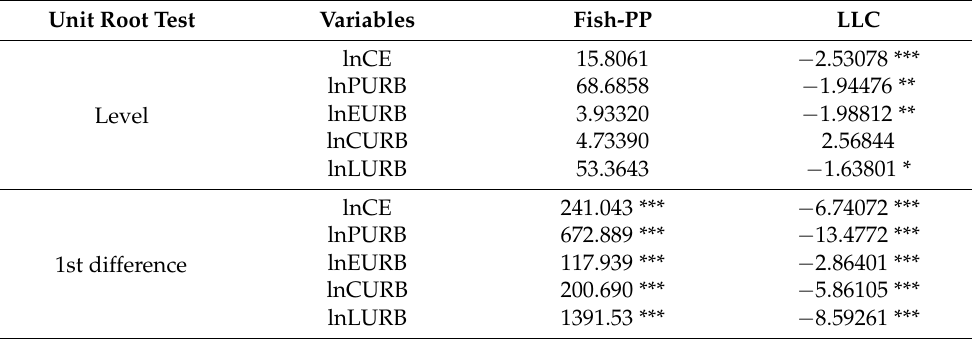
Table 3. Unit root test results of whole panel data.